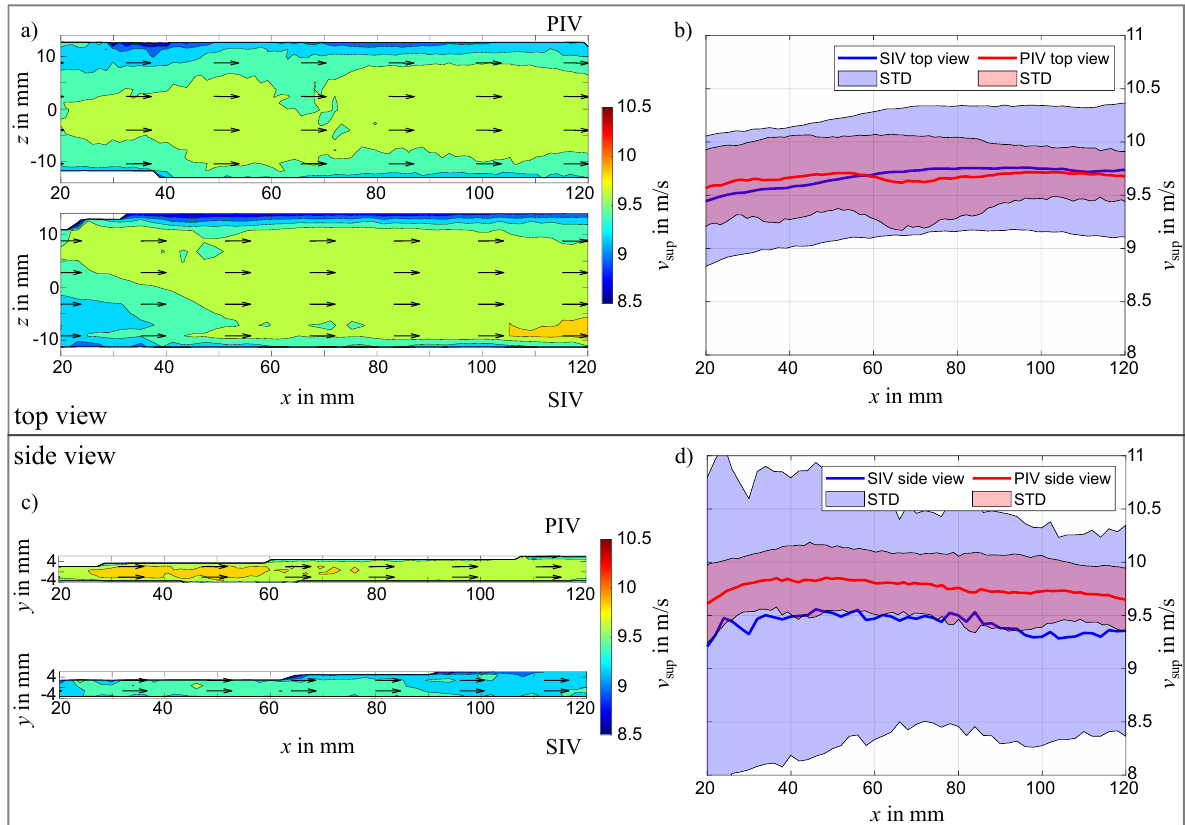
Figure 8. Measured and averaged velocity fields for a volume flow of 26.6L/min in the top view and the side view of the MWF jet with PIV and SIV: ( a ) Average 2d velocity field from the top view. ( b ) Mean velocity and standard deviation (STD) of the top view measurement along the x -axis. ( c ) Average 2d velocity field from the side view. ( d ) Mean velocity and standard deviation (STD) of the side view measurement along the x